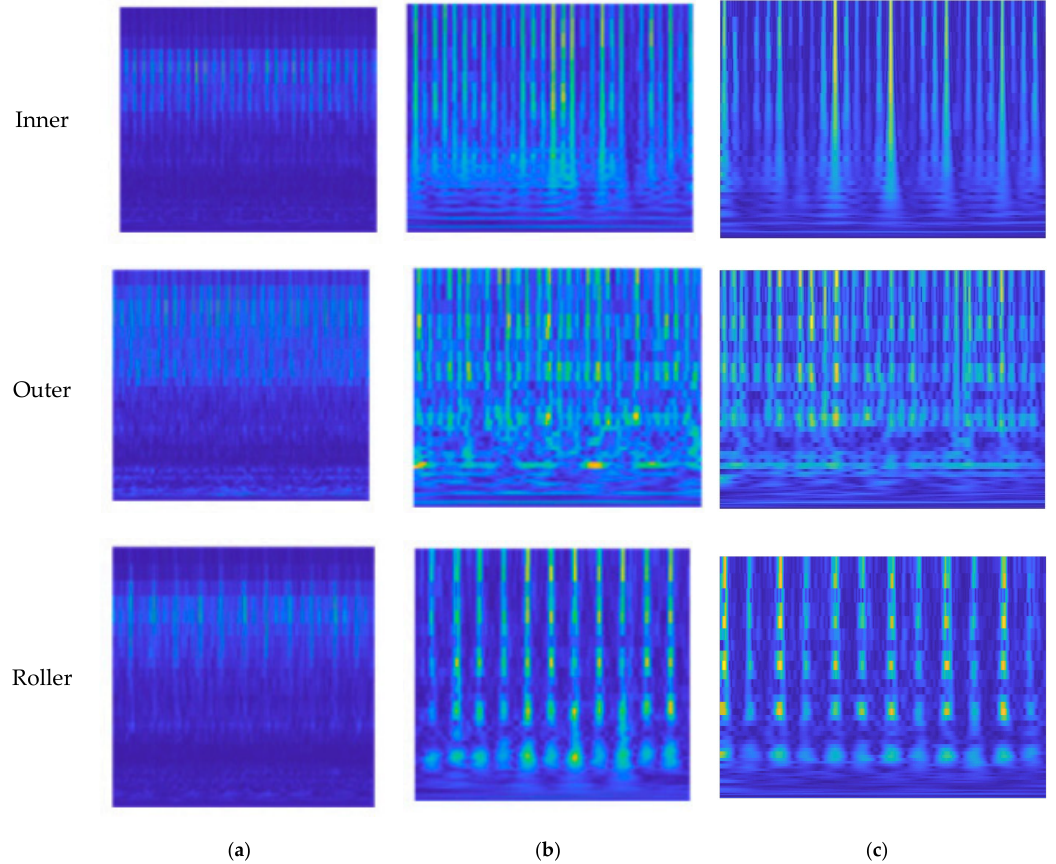
Figure 11. The 2-D representation of the ( a ) conventional wavelet spectrogram (CWS), ( b ) DSWI, and ( c ) EEMD + envelope analysis with CWT (our proposed method).